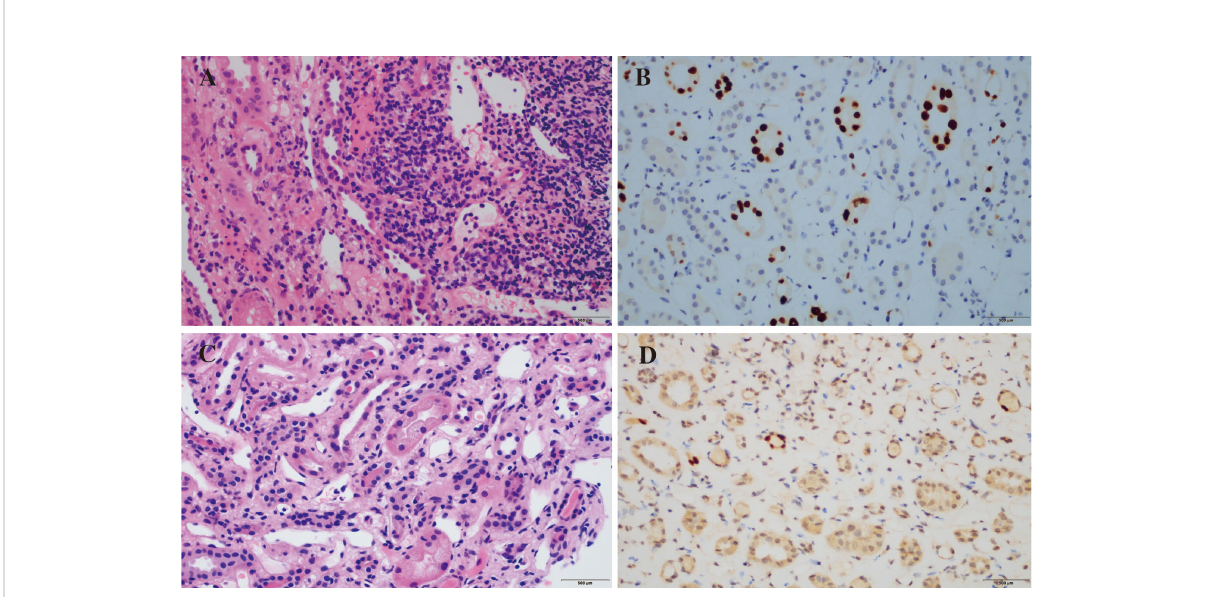
FIGURE 1 Pathological fi ndings of renal allograft biopsy. Pathological fi ndings before BAS treatment. Numerous graft-in fi ltrating cells can be seen in the renal interstitium (i2) ( A , HE staining). Nuclear expression of SV40-T antigen ( B , immunohistochemistry). The second renal allograft biopsy. Microvacuolar degeneration of renal tubular cells ( C , HE staining). Persistent nuclear expression of SV40-T ( D ,